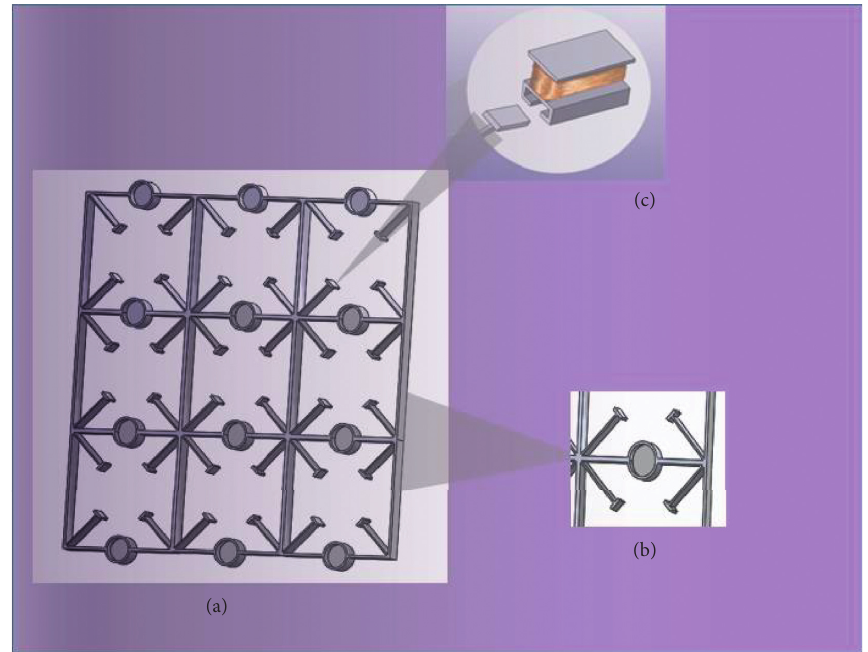
Figure 1: Concept and design of the metamaterial vibration attenuation energy harvesting structure presented in this work: (a) design layout of the metamaterial structure; (b) building block, i.e., local resonator. Each local resonator consists of four angled cantilevers and a central magnet mass, and (c) the tip of each cantilever is made of insertion where copper coils are placed for power